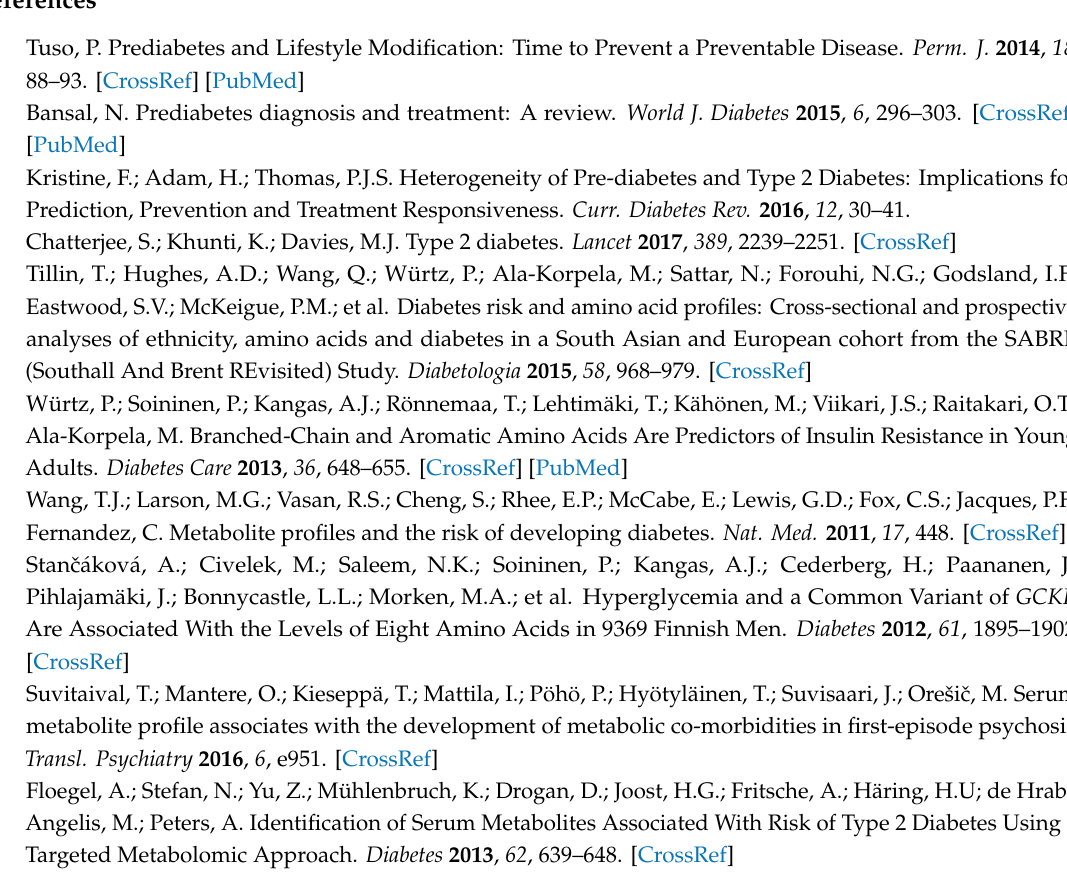
Figure S1: Derivatization reaction. Figure S2: Structures of compounds of interest, amino acids, and amino acid-related compounds, Figure S3: Structures of compounds of interest, bile acids, Figure S4: Structures of compounds of interest, small organic acids and other metabolites of interest, Figure S5: (a) MS-spectrum and (b) MS / MS-spectrum of taurine, Figure S6: (a) MS-spectrum and (b) MS / MS-spectrum of azelaic acid, Figure S7: (a) MS-spectrum and (b) MS / MS-spectrum of gamma-butyrobetaine, Figure S8: (a) MS-spectrum and (b) MS / MS-spectrum of glycolic acid, Figure S9: (a) MS-spectrum and (b) MS / MS-spectrum of